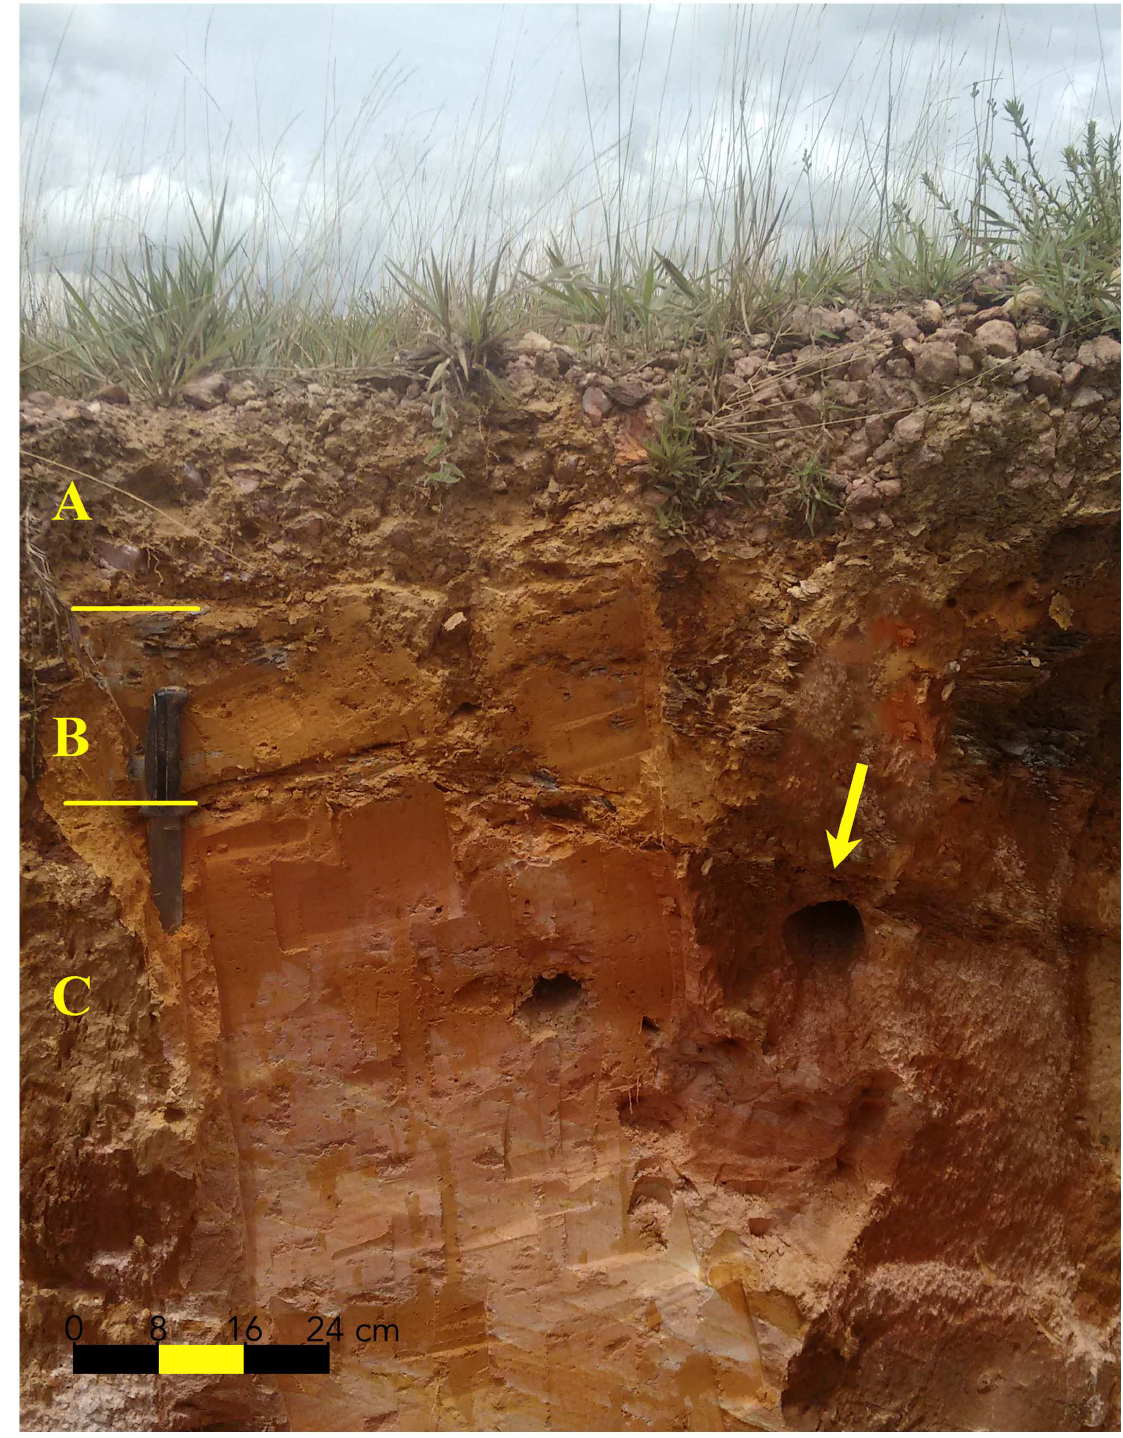
Fig 3. Soil profile showing the identification of the horizons (A, B, and C) containing Geosittapoeciloptera nest cavities in the Upper Rio Grande Grasslands, southeastern Brazil. The yellow arrow indicates the location of the nest cavity on the horizon C. Photo: RCM.